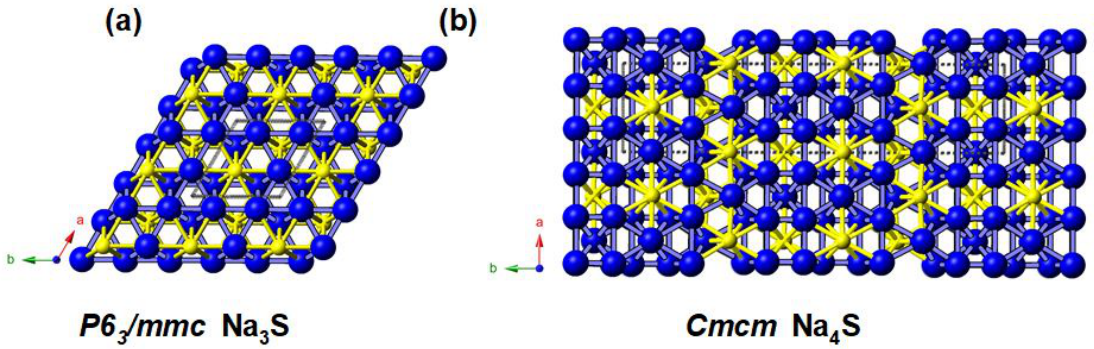
Figure 9. Predicted crystal structures of sodium rich phases at 200 GPa: ( a ) P 6 3 / mmc -Na 3 S; and ( b ) Cmcm -Na 4 S. Sodium atoms are colored blue, and sulfur atoms are yellow. Blue and yellow lines represent nearest neighbor